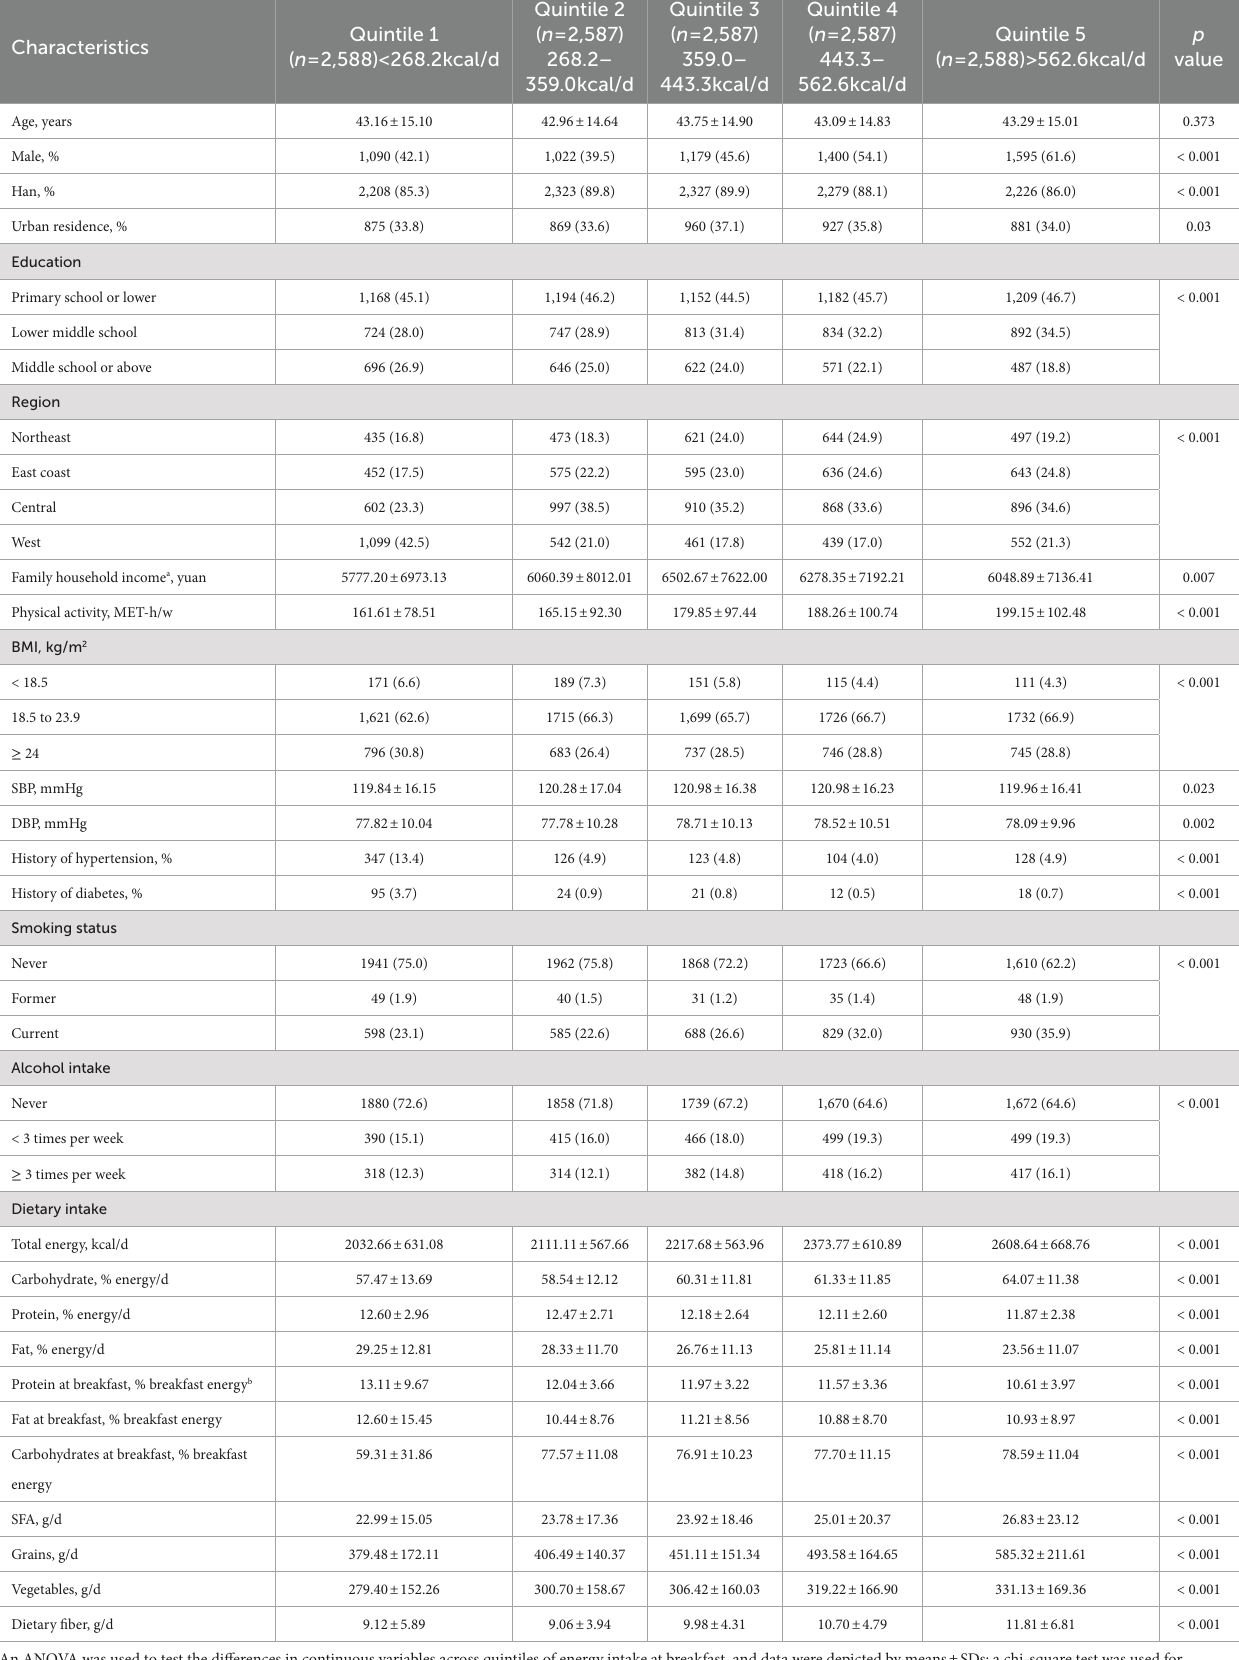
TABLE 1 Baseline characteristics according to quintiles of energy intake at breakfast: CHNS, 1997–2011.